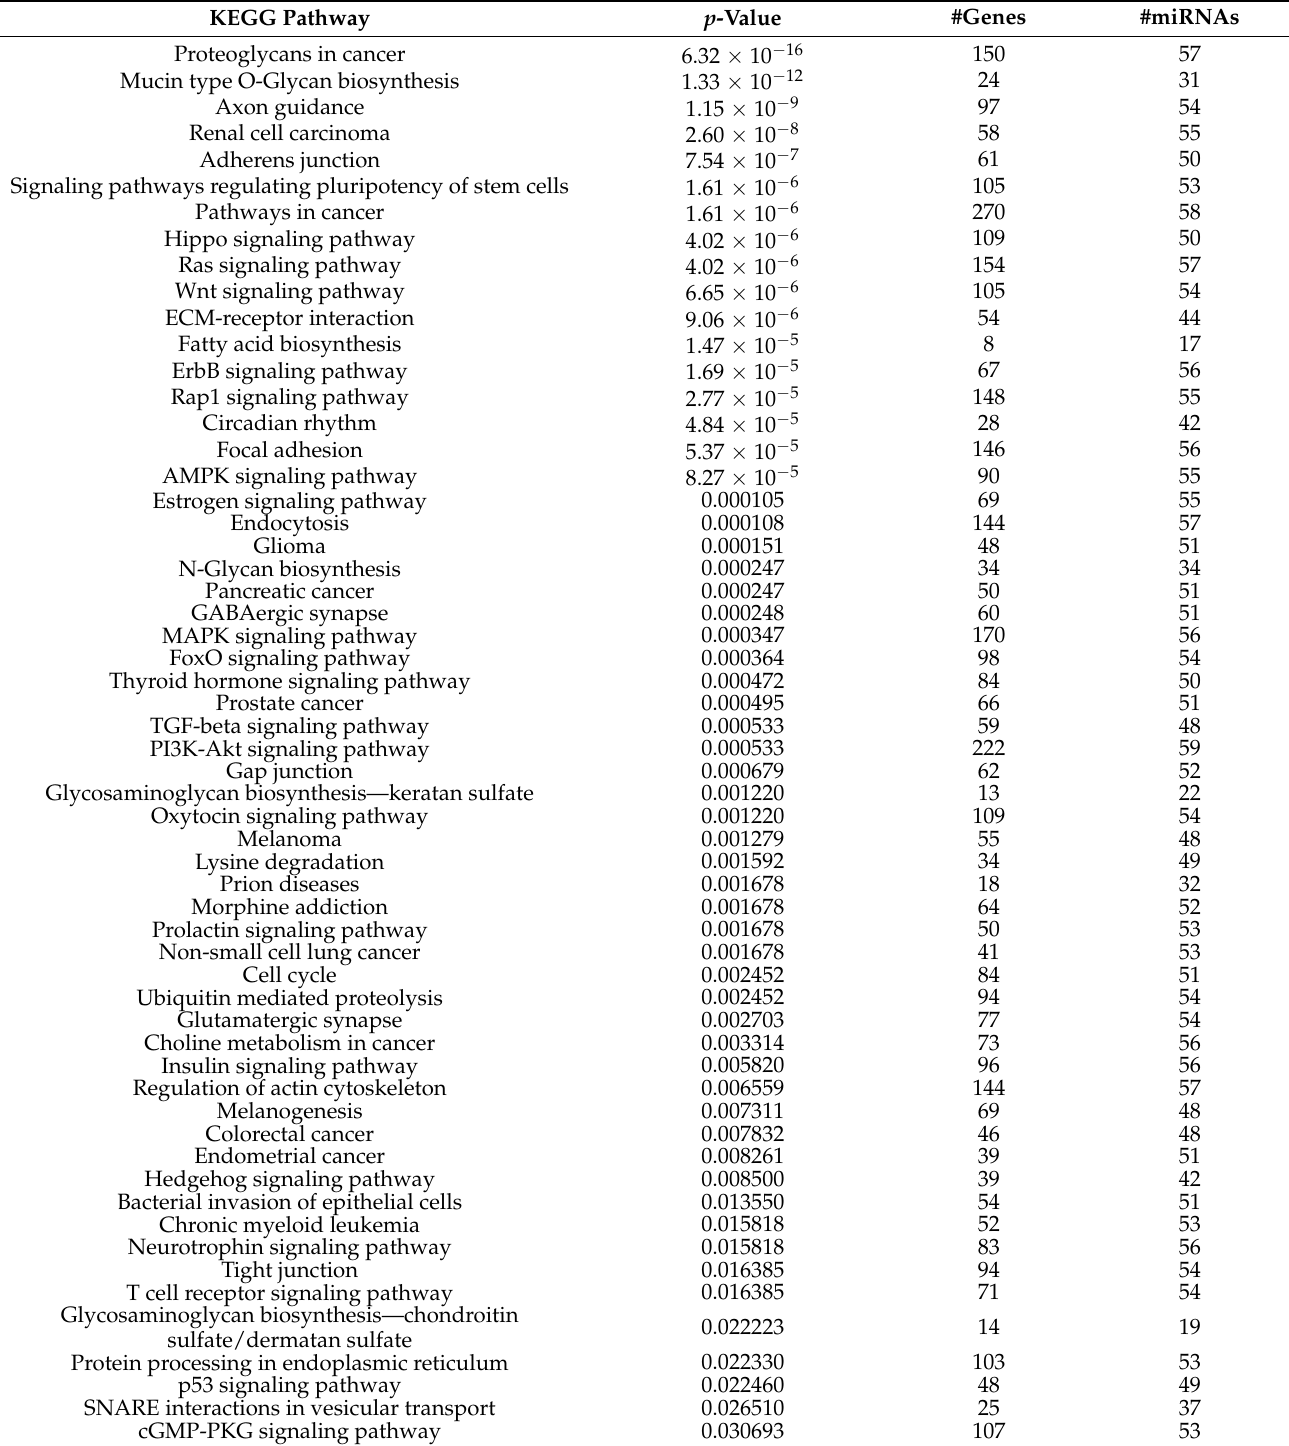
Table 3. Enriched pathways from the dataset. A total of 62 miRNAs were enriched in 58 pathways. KEGG